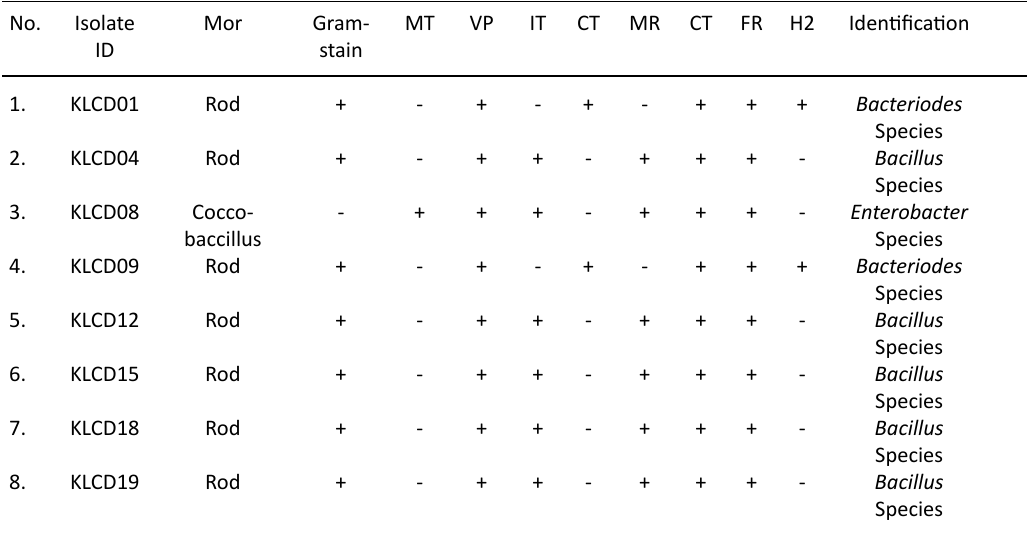
Table 2. Biochemical and morphological characteristics of selected cellulose degrading bacteria No. Isolate Mor Identification ID stain 1.